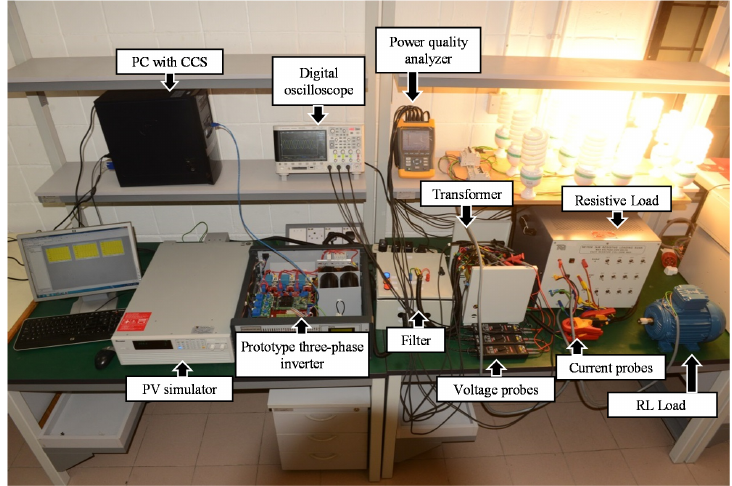
Figure 10. Experimental setup for the proposed PV inverter control system.